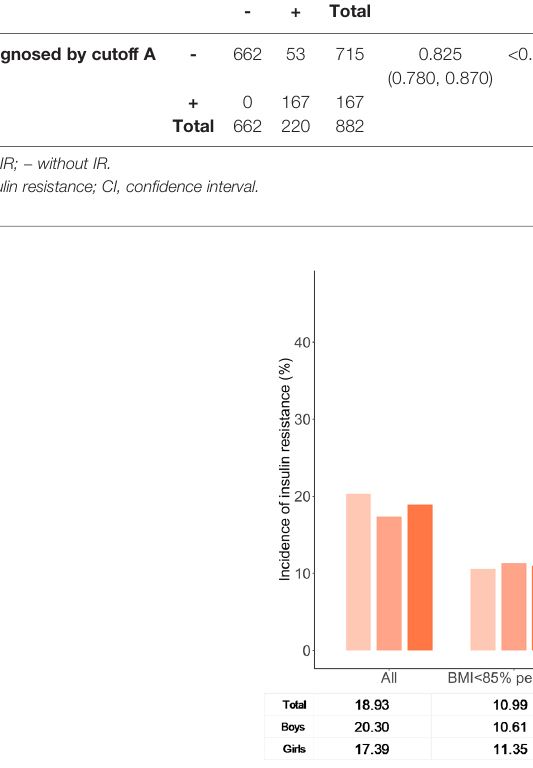
FIGURE 2 | The incidence of insulin resistance based on body mass index